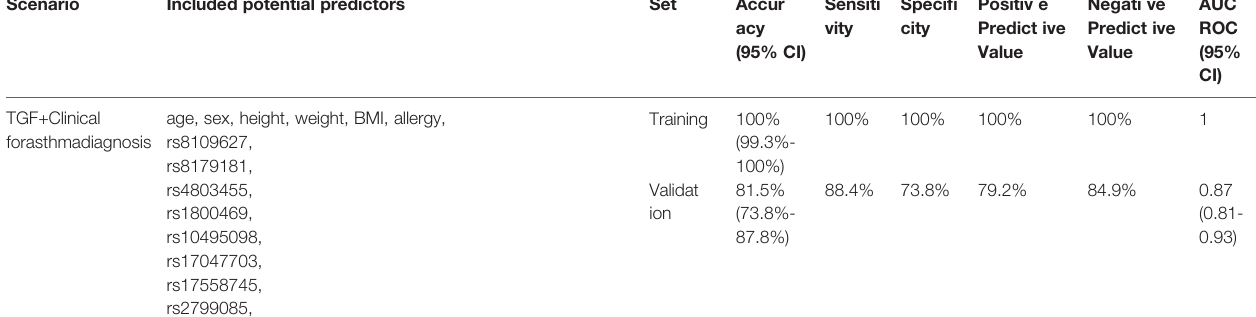
TABLE 5 | Performance metrics of developed fi nal data-mining models.